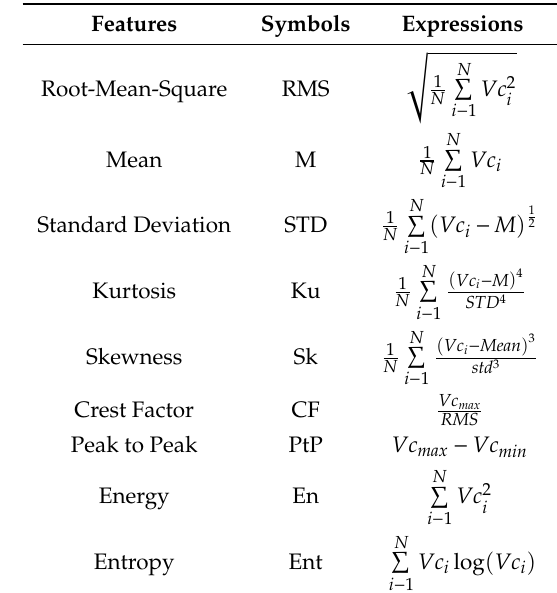
Table 1. Time-domain features.